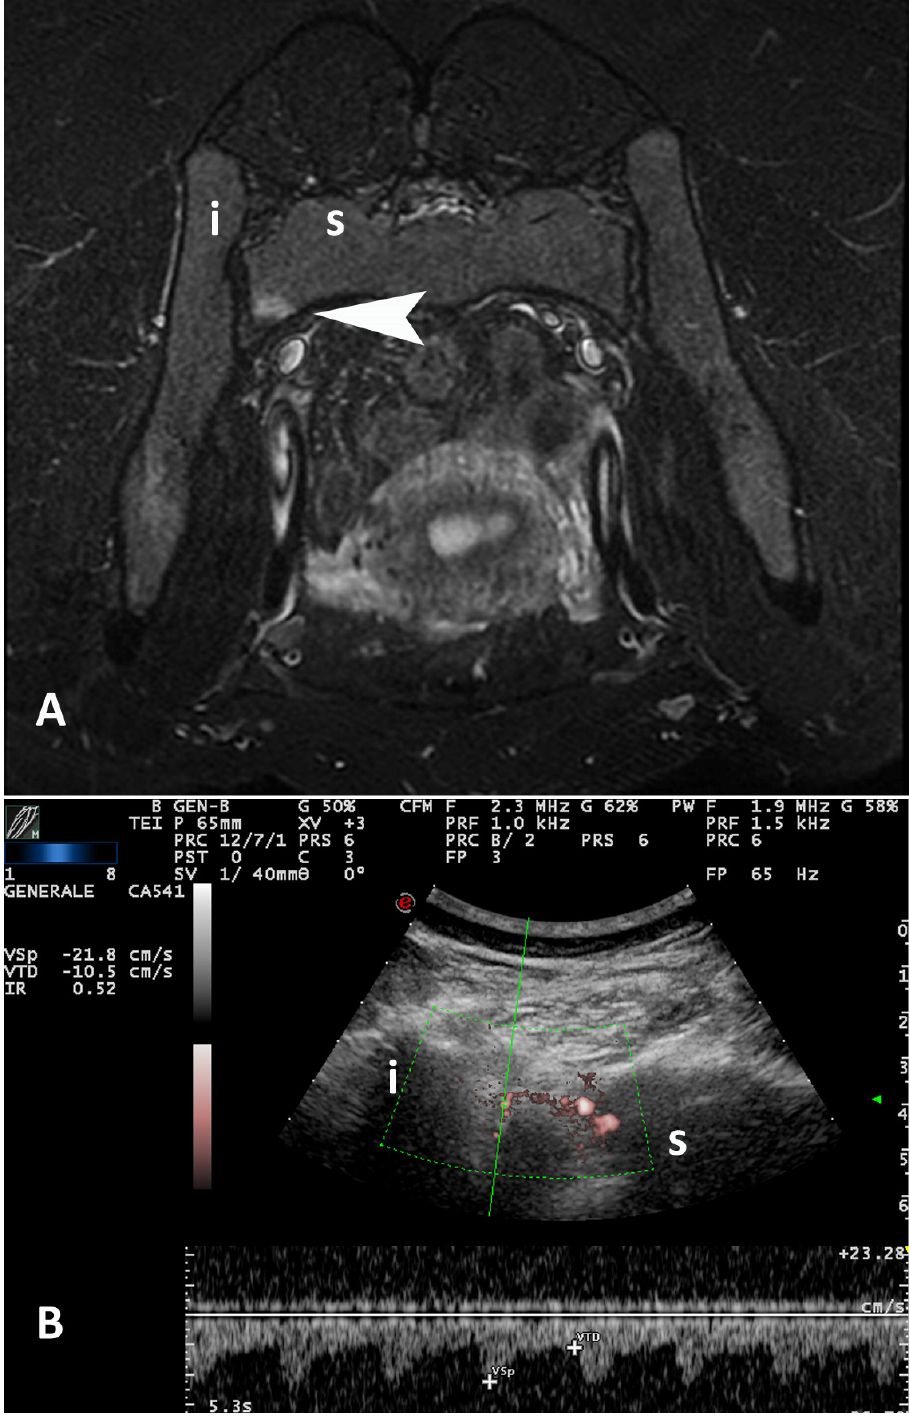
Figure 2. 17 − year − old girl with jSpA. ( A ) Magnetic resonance imaging (MRI) (the image has been rotated of 180 ◦ for a better comparison with the corresponding ultrasound scan): a short − tau inversion recovery (STIR) axial image shows a focal hyper − intense area of bone marrow edema (arrowhead) in the sacral side of left SIJ due to sacroiliitis. ( B ) PDUS/SWA over the same SIJ demonstrates a low resistance flow (RI 0.52), suggesting vasodilatation due to sacroiliitis. The majority of vessels observed in the posterior − superior portion of SIJ originate from branches of the posterior division of superior gluteal artery, which emerge from sacral foramina (note the intense vascular signals into the sacral foramen). i = ilium; s =